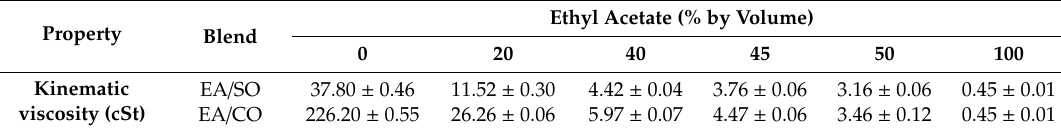
Table 4. Viscosity values at 40 °C (cSt, centistokes) of ethyl acetate (EA)/sunflower oil (SO) and EA/castor oil (CO) double blends. Errors expressed as standard deviation have been calculated from average three measurement.